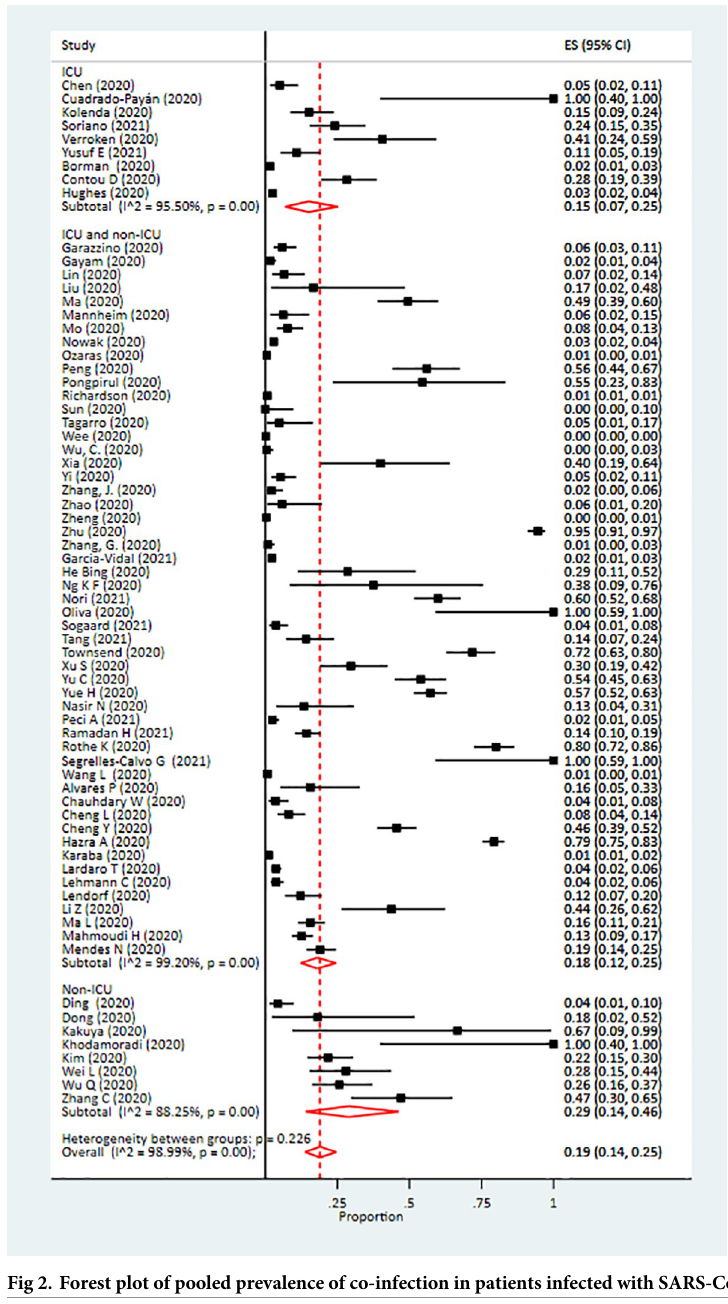
Fig 2. Forest plot of pooled prevalence of co-infection in patients infected with SARS-CoV-2. The overall prevalence of comorbidities was 42% (95% CI: 35%-49%). Among those with co-infections, the prevalence of comorbidities was 32% (95% CI: 24%-41%), while it was 54% (95% CI: 42%-65%) among those who were super-infected. Patients with a co-infection or superinfection had a higher odds of dying than those who only had SARS-CoV-2 infection (odds ratio [OR] = 3.31, 95% CI: 1.82–5.99). Subgroup analy- sis of mortality showed similar results, where the odds of death was higher among patients who were co-infected (OR = 2.84; 95% CI: 1.42–5.66) and those who were super-infected